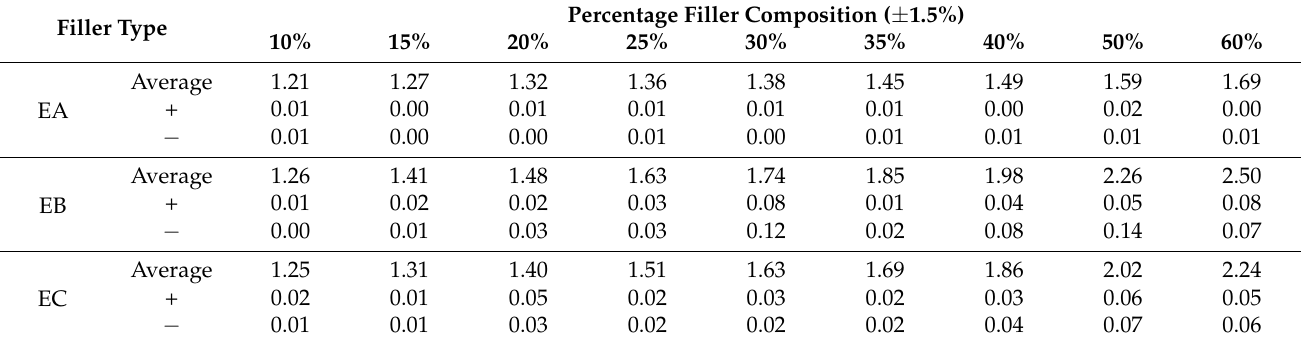
Table 6. Summary of Density values for EA, EB, and EC.